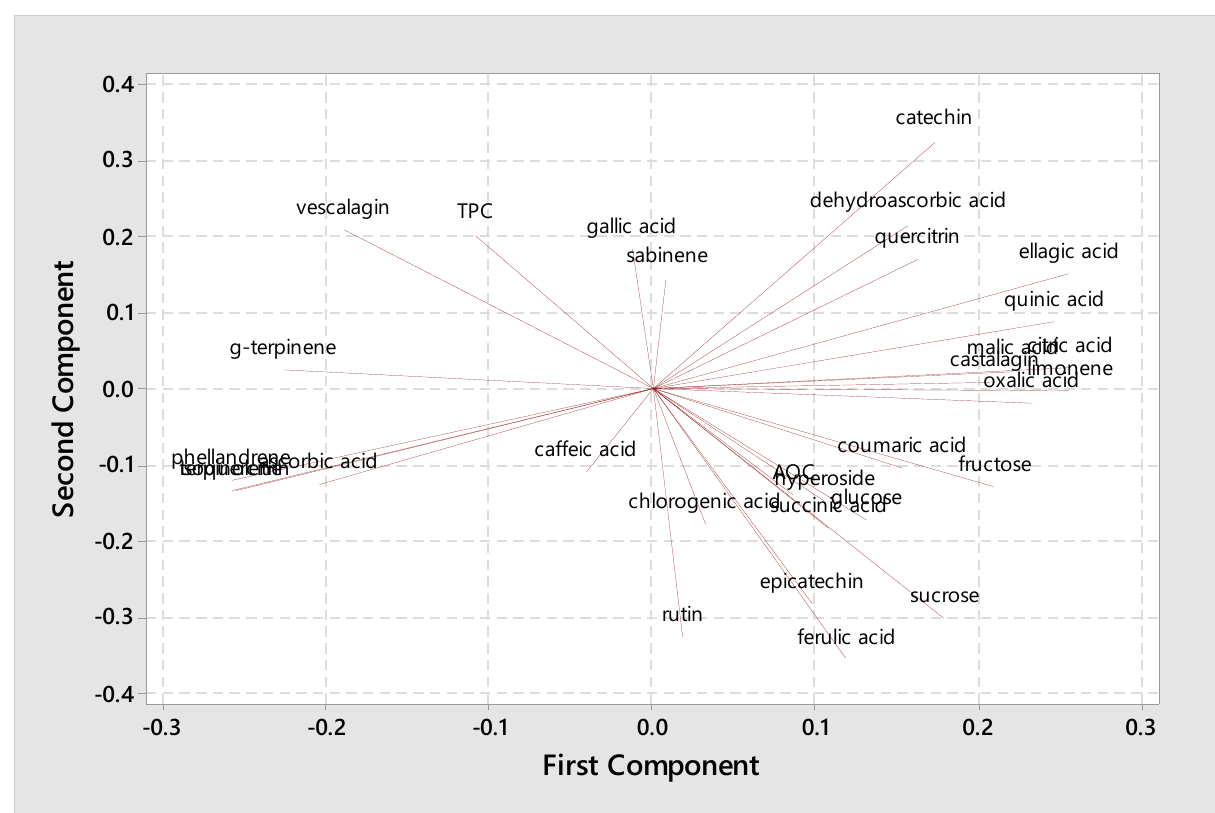
Figure 7. Principal component analysis (PCA_2) score plot of the tested CFs. Mean values ( n = 3) were included for each sample. Flour IDs were reported in Table 1.